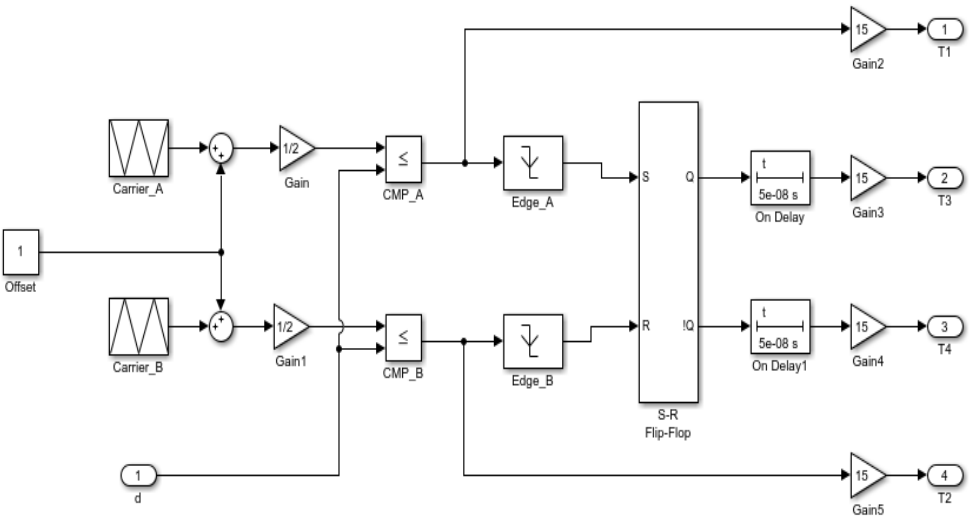
Figure 6. MATLAB Simulink inside “PWM_generator” sub-system.